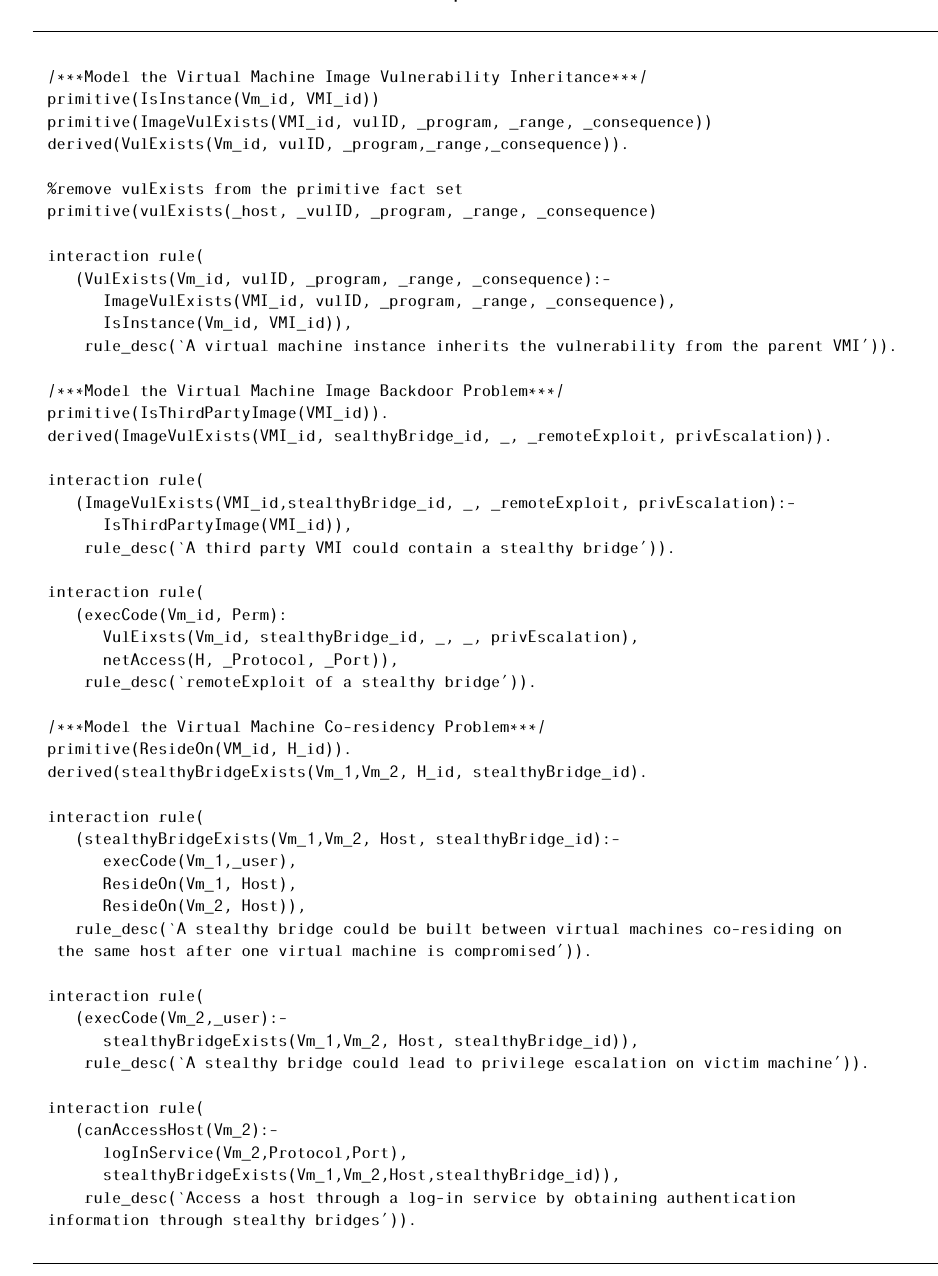
Table 1. a Sample Set of Interaction